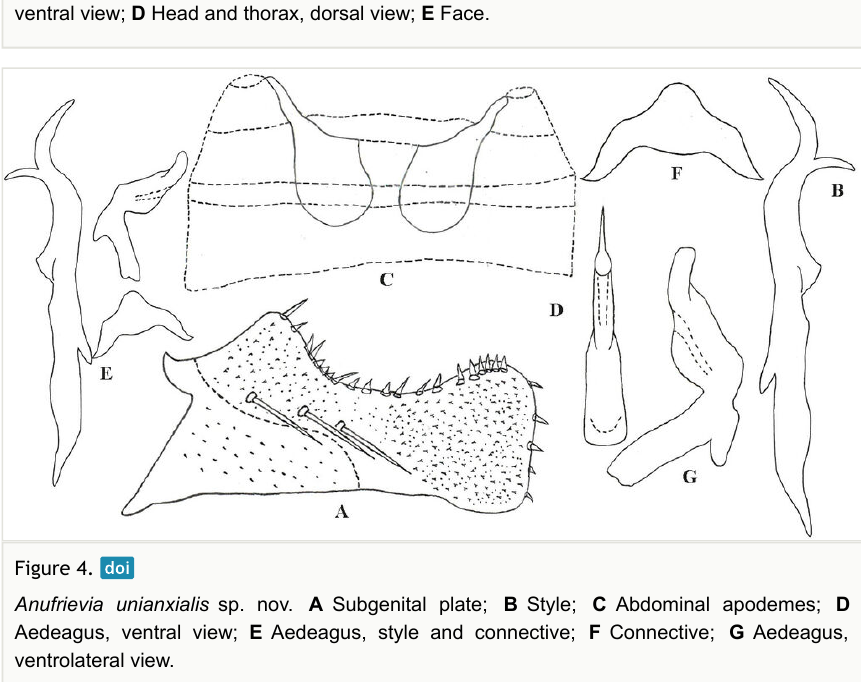
Figure 3. Anufrievia unianxialis sp. nov. A Habitus, dorsal view; B Habitus, lateral view; C Habitus, ventral view; D Head and thorax, dorsal view; E Face.